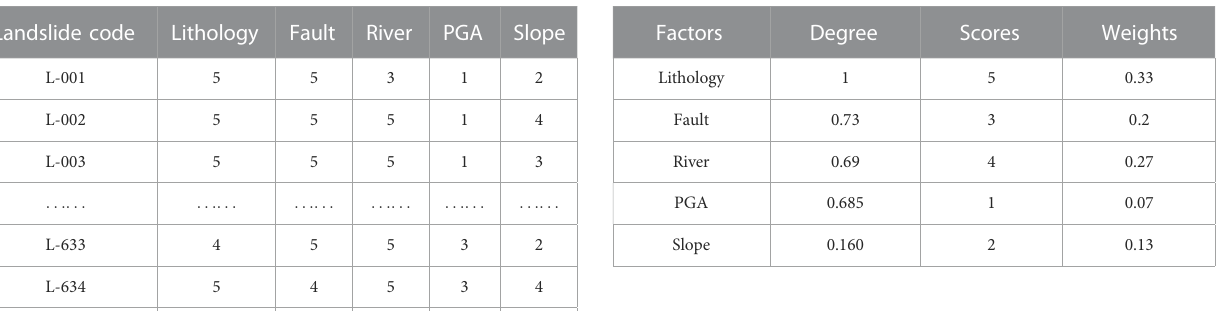
TABLE5Relatedcoef fi cients andweightsoflandslide factorsinthe